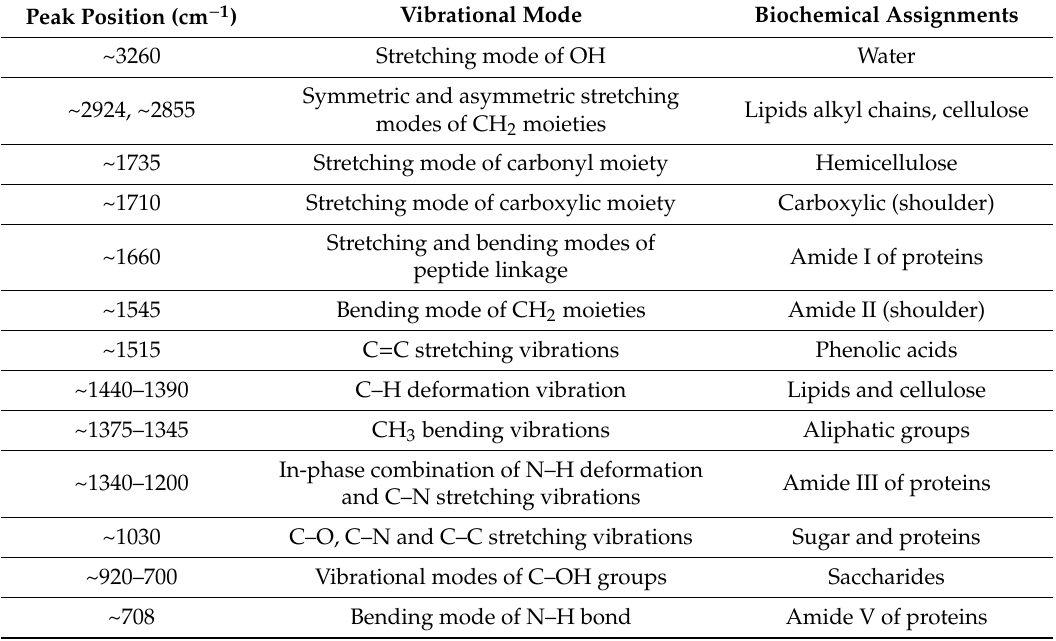
Table 3. Meaningful FTIR-ATR peaks of pollen samples: peak position in terms of wavenumbers (cm − 1 ), vibrational mode and chemical